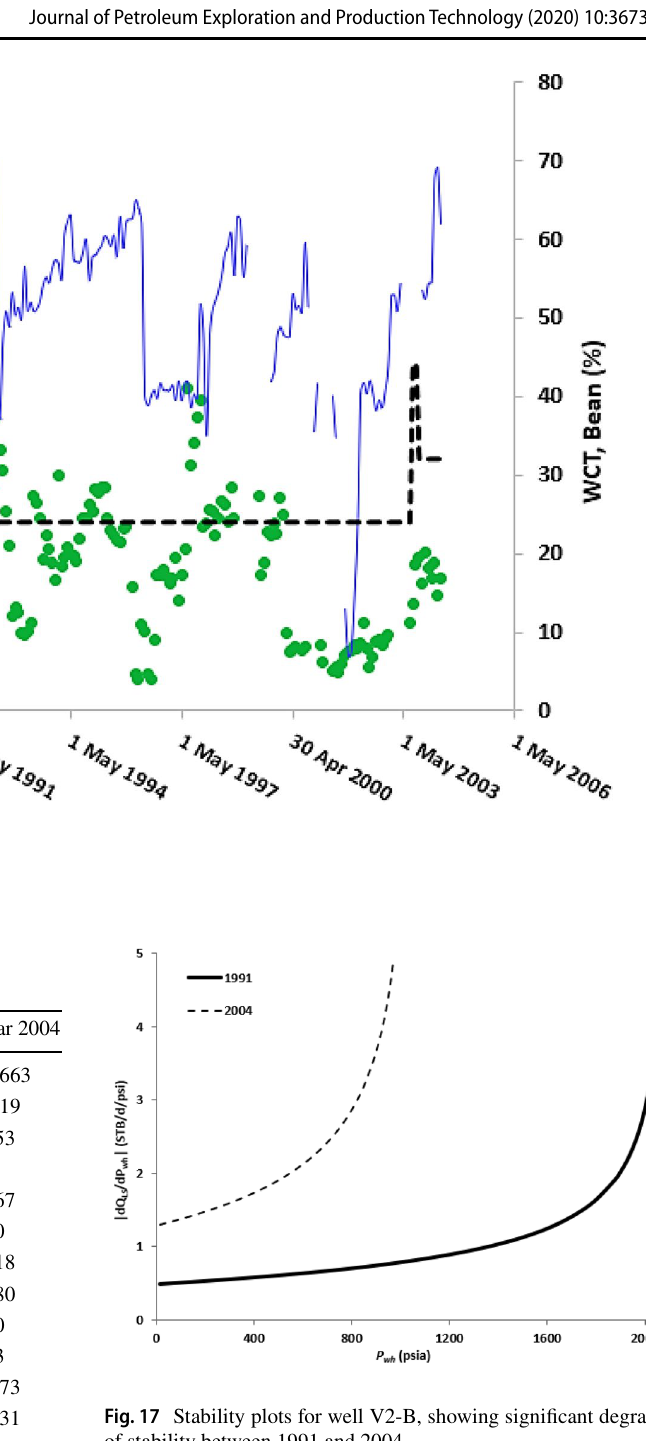
Fig. 17 Stability plots for well V2‑B, showing significant degradation of stability between 1991 and